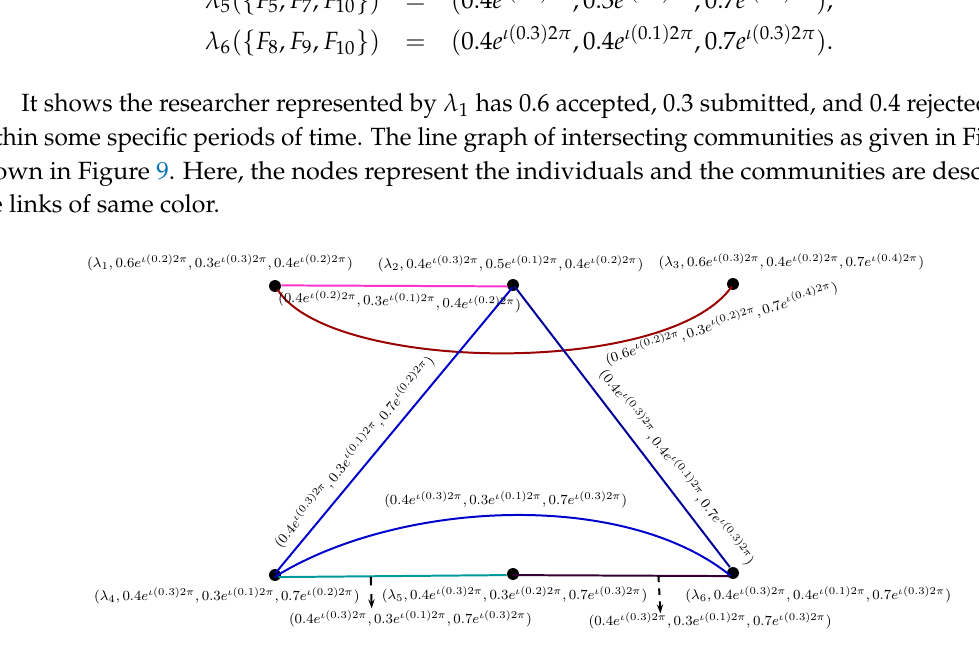
Figure 9. Line graph of intersecting research